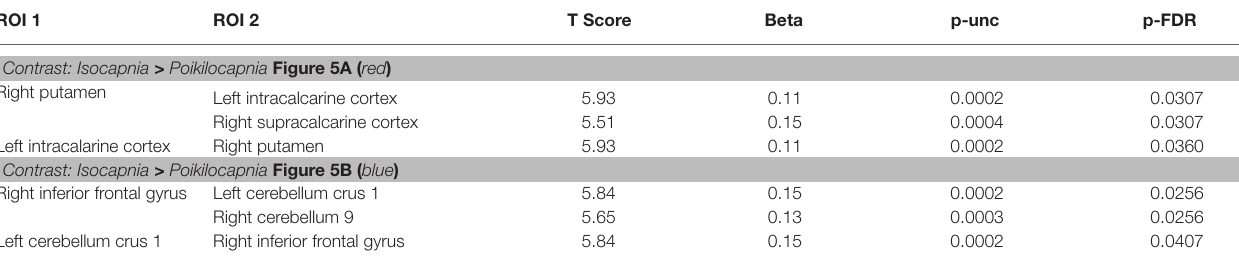
TABLE 1 | ROI-to-ROI functional connectivity results within a whole-brain parcellations of 174 ROIs. ROI 1 ROI 2 T Score Beta p-unc p-FDR Contrast: Isocapnia > Poikilocapnia Figure 5A ( red ) Right putamen